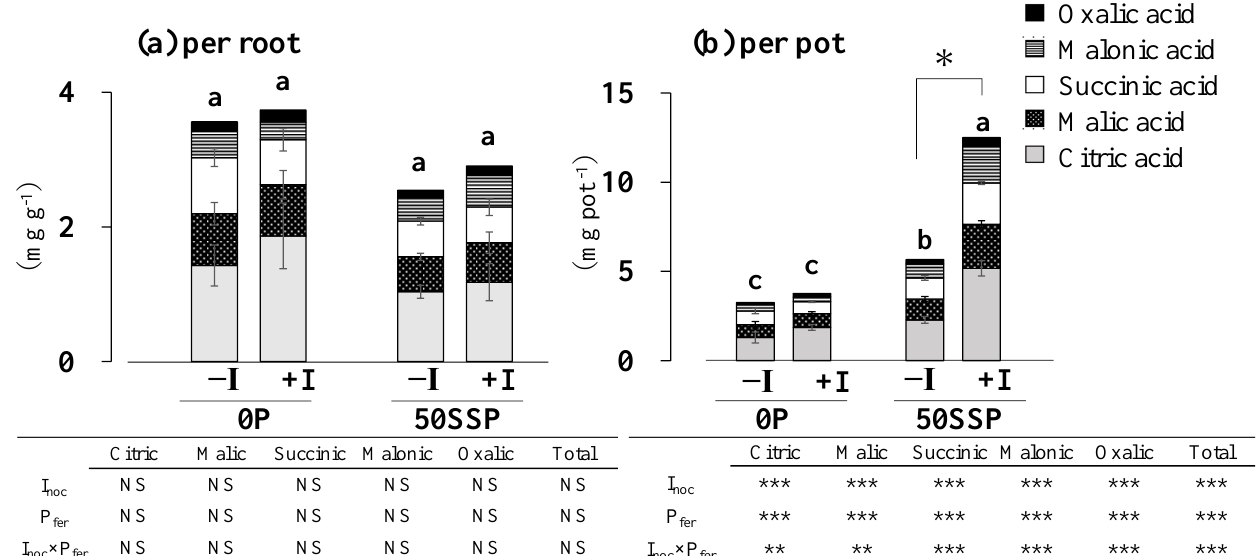
Figure 3. The amount of organic acid ( a ) per root, ( b ) per pot. − I/+I and 0P/50SSP indicate Rhizobium inoculation and P fertilization. Bars indicate the error bar (n = 5). Lowercase letters indicate the significant difference between the treatments, according to Tukey’s posthoc test ( p < 0.05). * represents significant differences between the − I and +I treatments under 0P and 50SSP treatments according to Student’s t -test ( p < 0.05). NS, *, **, and *** in inserted tables indicate not significant, p < 0.05, p < 0.01, and p < 0.001, respectively, estimated using two-way ANOVA; I noc and P fer indicate the effect of Rhizobium inoculation and P fertilizer, respectively.